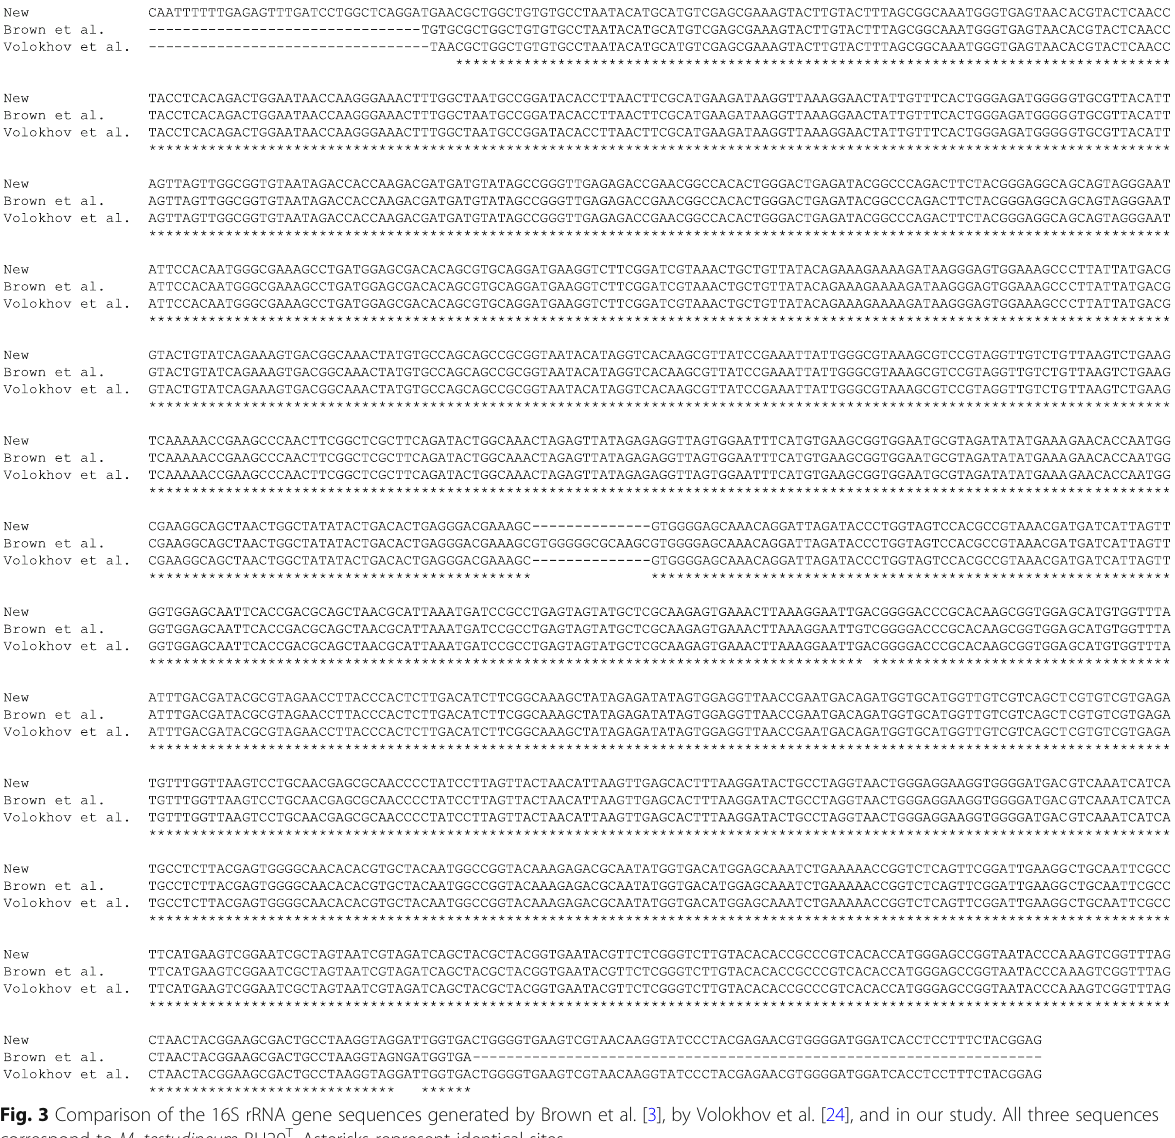
Fig. 3 Comparison of the 16S rRNA gene sequences generated by Brown et al. [3], by Volokhov et al. [24], and in our study. All three sequences correspond to M. testudineum BH29 T . Asterisks represent identical